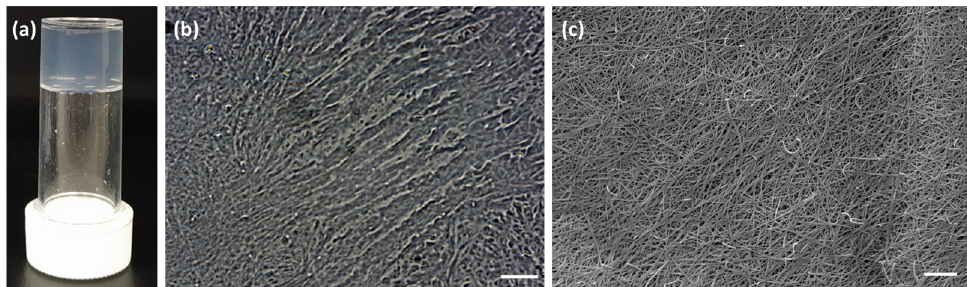
Figure 7. ( a ) Photograph of hydrogel 10 and pictures of fibrillar assemblies formed by dried hydrogel 10 obtained with ( b ) optical microscope (scale bar: 25 µm) and ( c ) scanning electron microscope (scale bar: 5 µm).